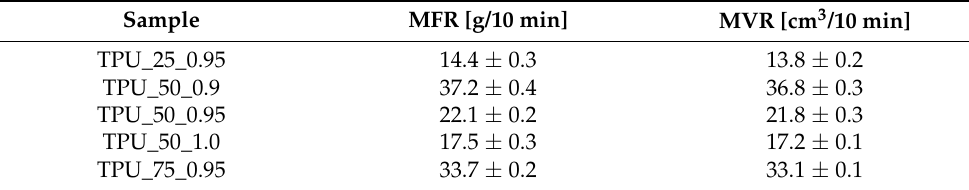
Table 6. The results of selected mechanical properties of the prepared green